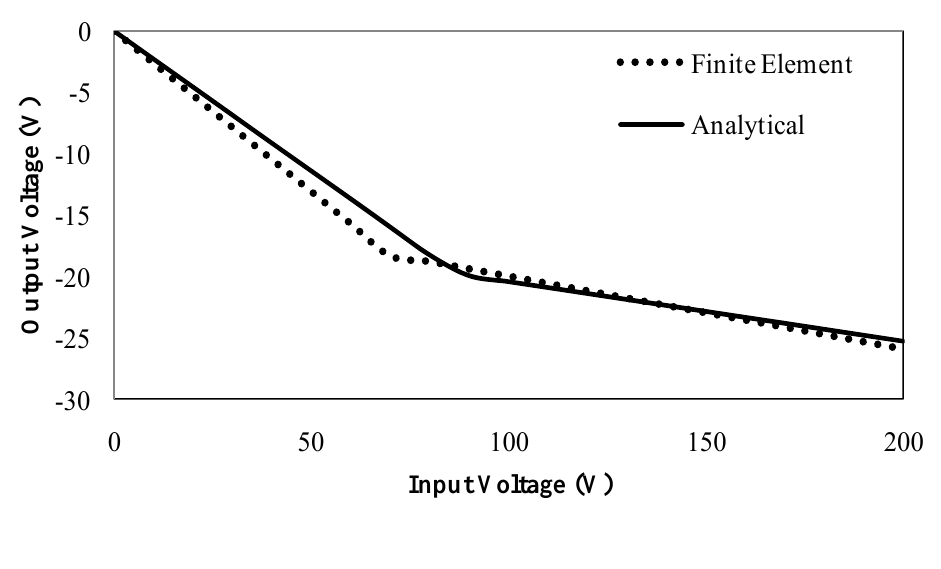
Figure 10. Comparison of induced voltages generated analytically and from both the elastic and plastic Finite Element